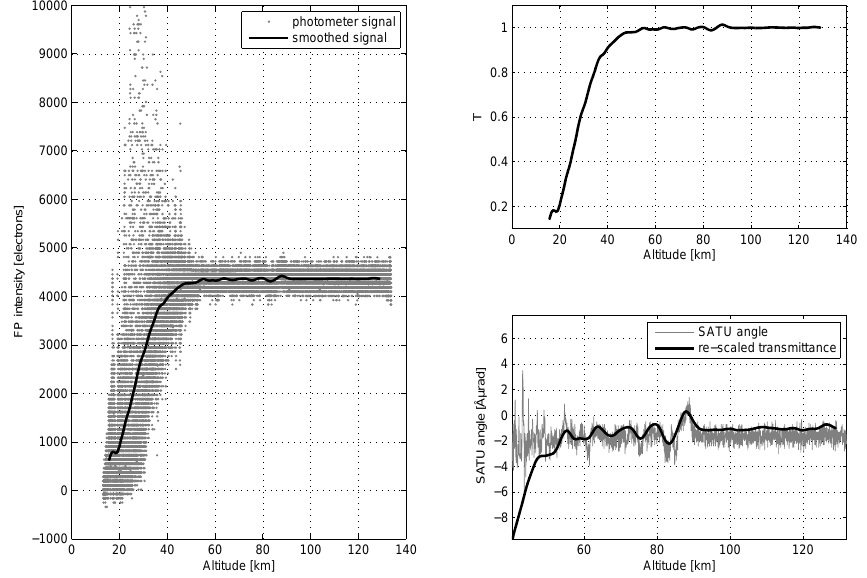
Figure 4. Left panel: raw and smoothed signals measured by the red GOMOS photometer during a full occultation. Right upper panel: associated transmittance profile. Right lower panel: SATU angle and re-scaled